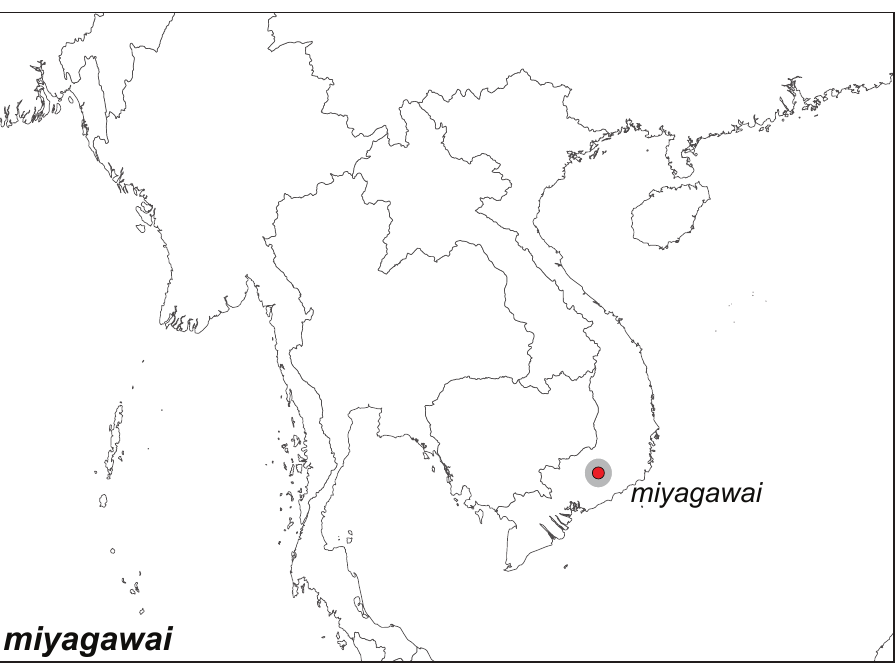
Figure 50. Distribution map of Elymnias miyagawai